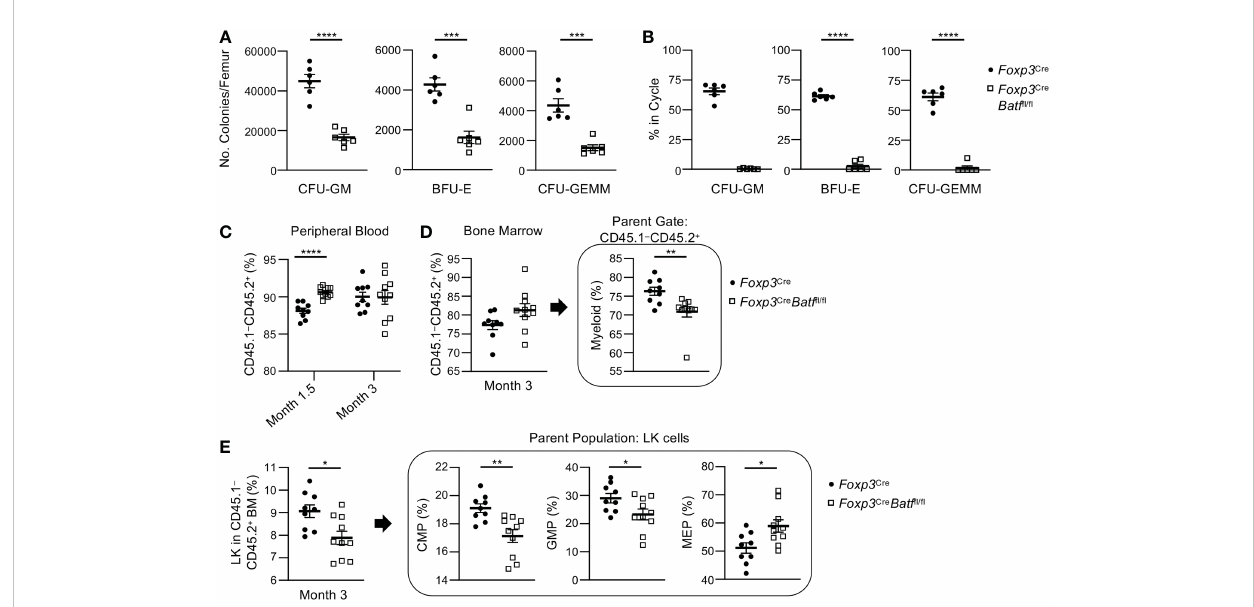
FIGURE 5 Foxp3 Cre Batf fl / fl BM demonstrate a decrease in functional myeloid progenitor cells ex vivo and altered engraftment potential in vivo compared to Foxp3 Cre BM. (A) Numbers of functional CFU-GM, BFU-E, and CFU-GEMM per femur in Foxp3 Cre and Foxp3 Cre Batf fl / fl mice ( n = 6 per group). (B) Percent of CFU-GM, BFU-E, and CFU-GEMM in cycle in the BM of Foxp3 Cre and Foxp3 Cre Batf fl / fl mice ( n = 6 per group). (C – E) Bone marrow transplantations were performed utilizing lethally irradiated Boy/J recipients (CD45.1 + CD45.2 – ) injected with a combination of donor BM (CD45.1 – CD45.2 + ) from Foxp3 Cre ( n = 9 mice per group) or Foxp3 Cre Batf fl / fl ( n = 10 mice per group) mice and support Boy/J BM cells. (C) Percent engraftment of donor cells (CD45.1 - CD45.2 + ) was examined in peripheral blood at months 1.5 and 3. (D) Percent engraftment and myeloid